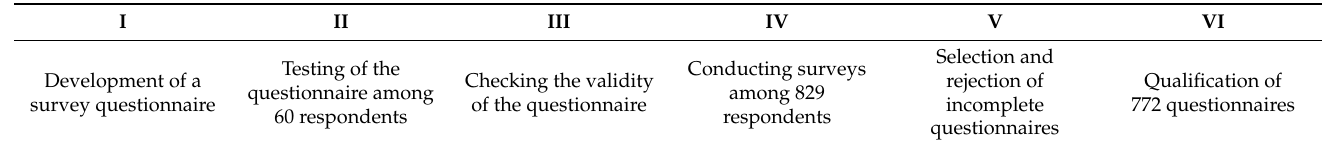
Table 1. Research